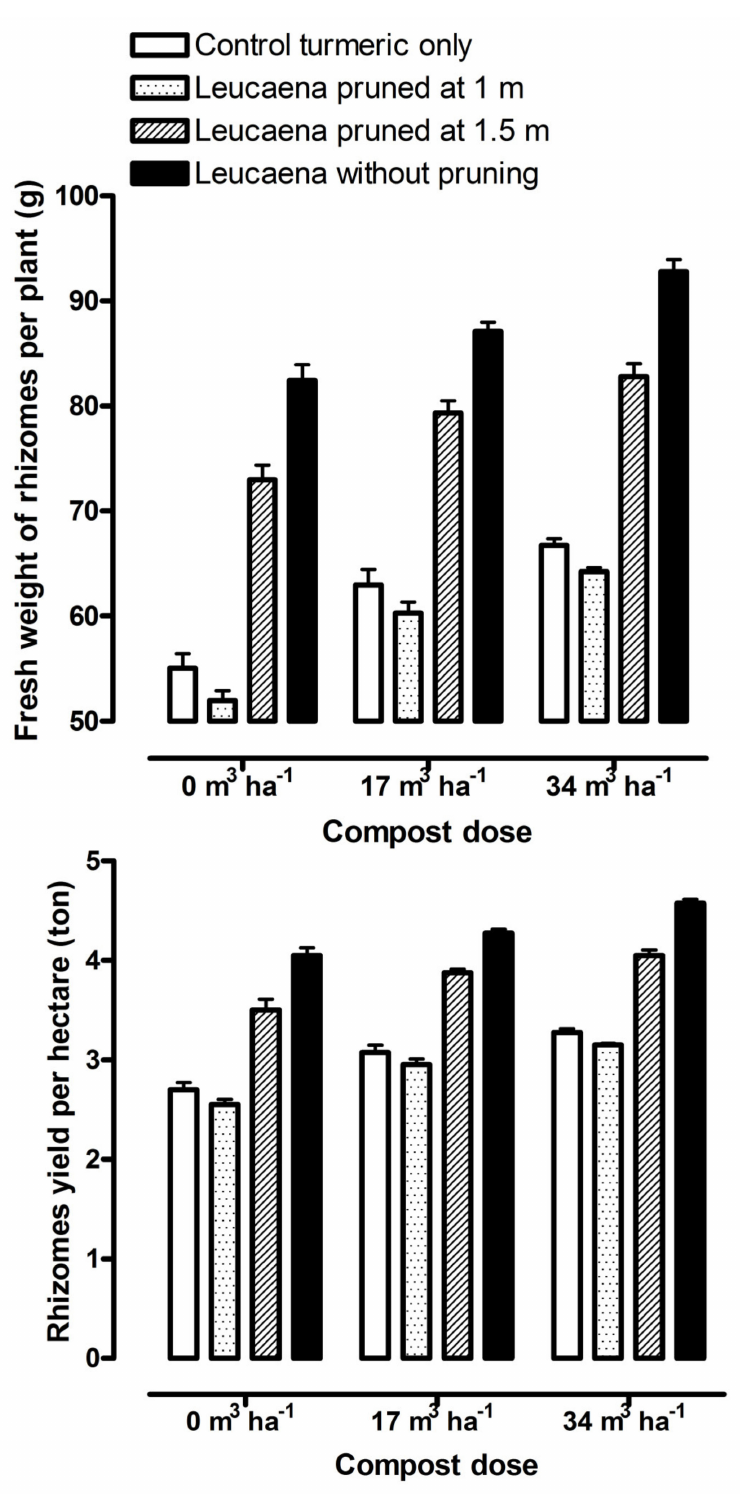
Figure 2. Fresh weight of rhizomes per plant (g) and fresh weight of rhizomes per hectare (ton) of Curcuma longa in response to alley-cropping and organic-compost treatments as pooled data of the two seasons of 2021 and